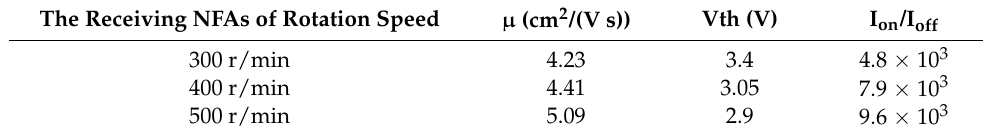
Table 1. Electrical characteristics of the differently-oriented Cu 3 (HITP) 2 NFAs-based FET.